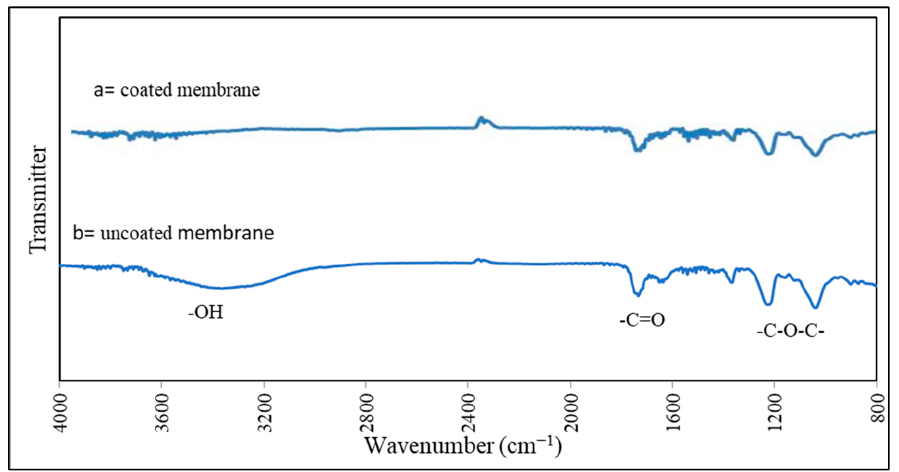
Figure 5. FTIR spectroscopy: ( a ) coated membrane; ( b ) uncoated membrane.